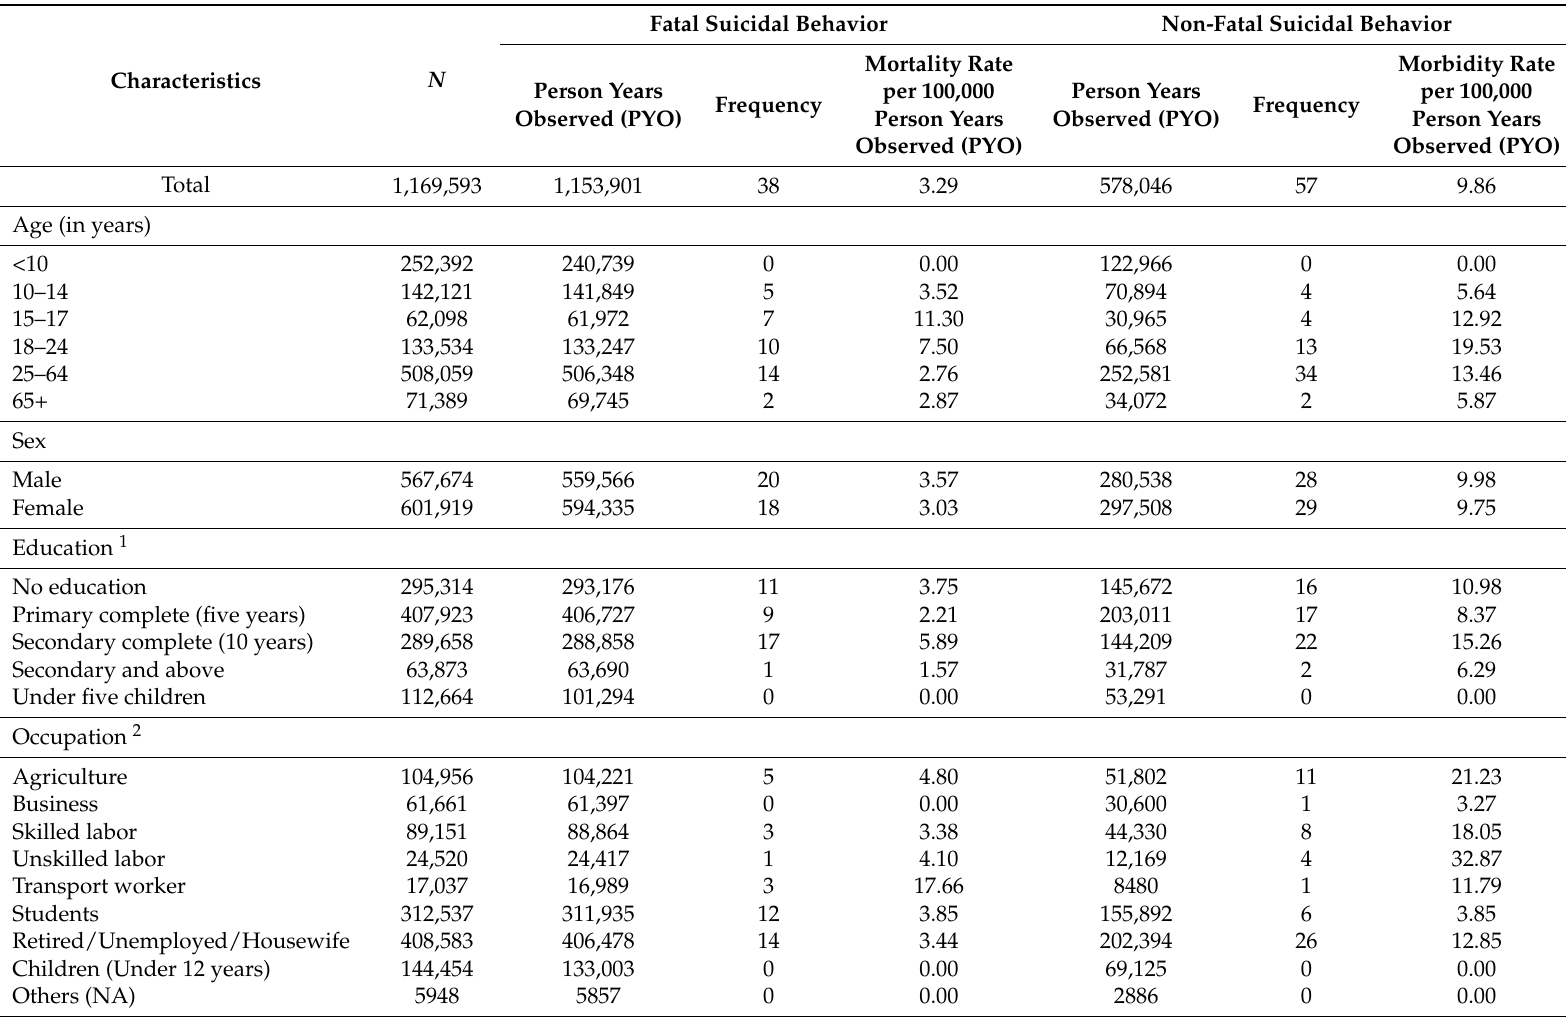
Table 2. Distribution of suicide and attempted suicide rates by socio-demographic and geographical factors, rural Bangladesh.